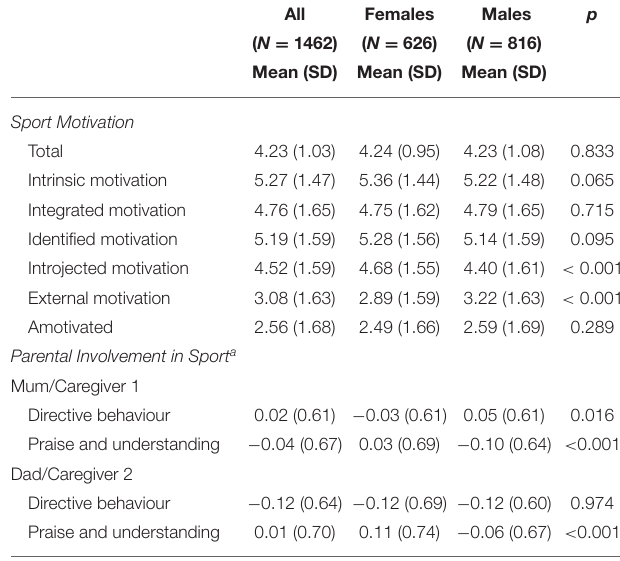
TABLE 5 | Summary of sport motivation and ratings of parental involvement in sport for participants who play sport. All